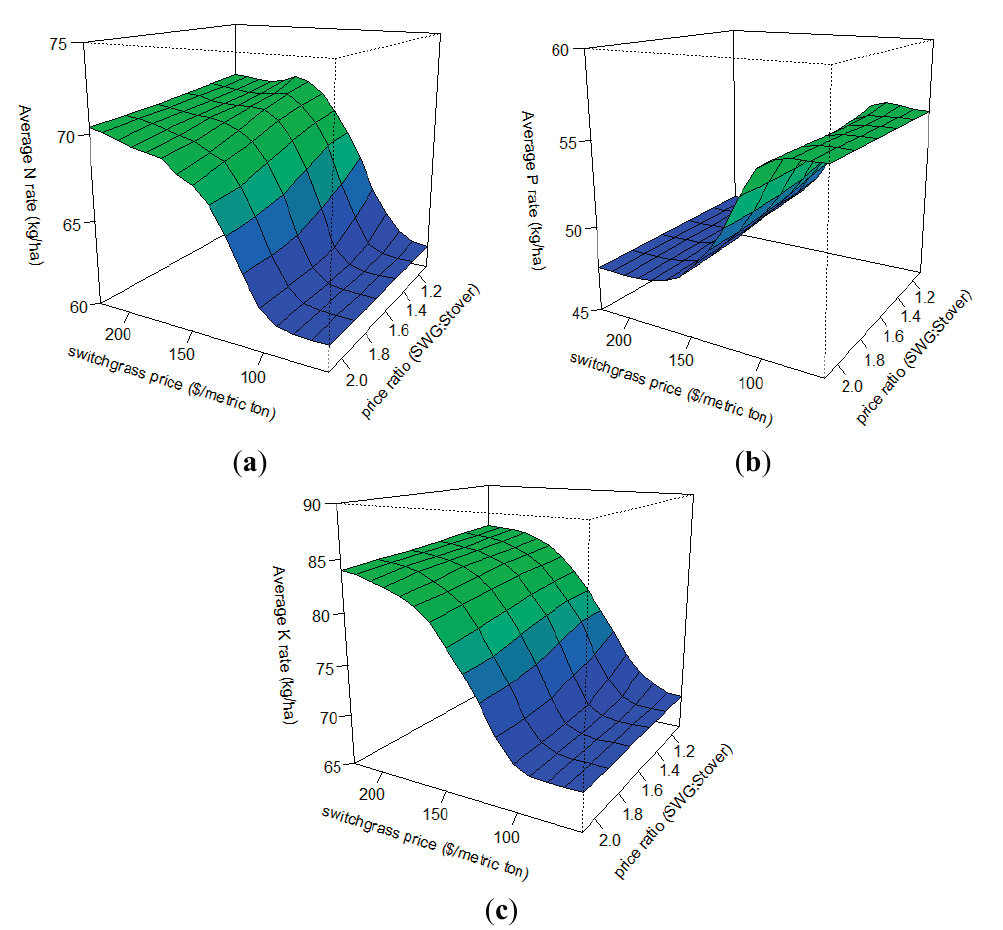
Figure 8. Watershed-averaged fertilizer rates (( a ) N; ( b ) P; and ( c ) K) from 960 simulations (16 levels of SWG price by 6 levels of switchgrass to corn stover price ratio, average of the 10 random samples based simulations for each